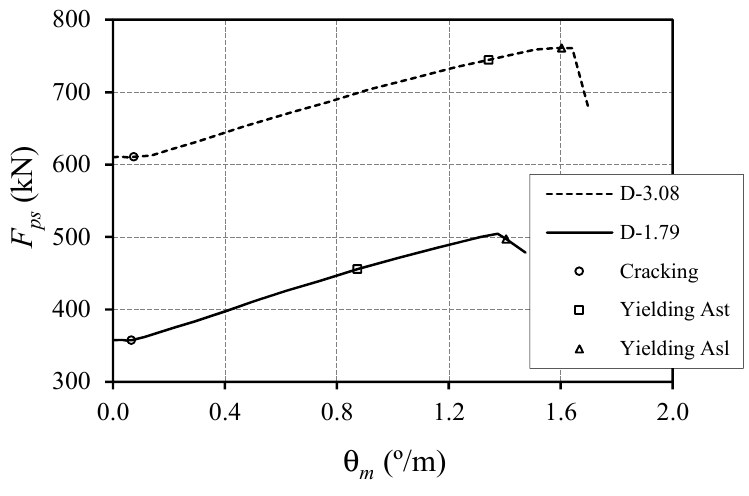
F − curves. Figure 9. F ps – θ m curves. Figure 9. θ ps m